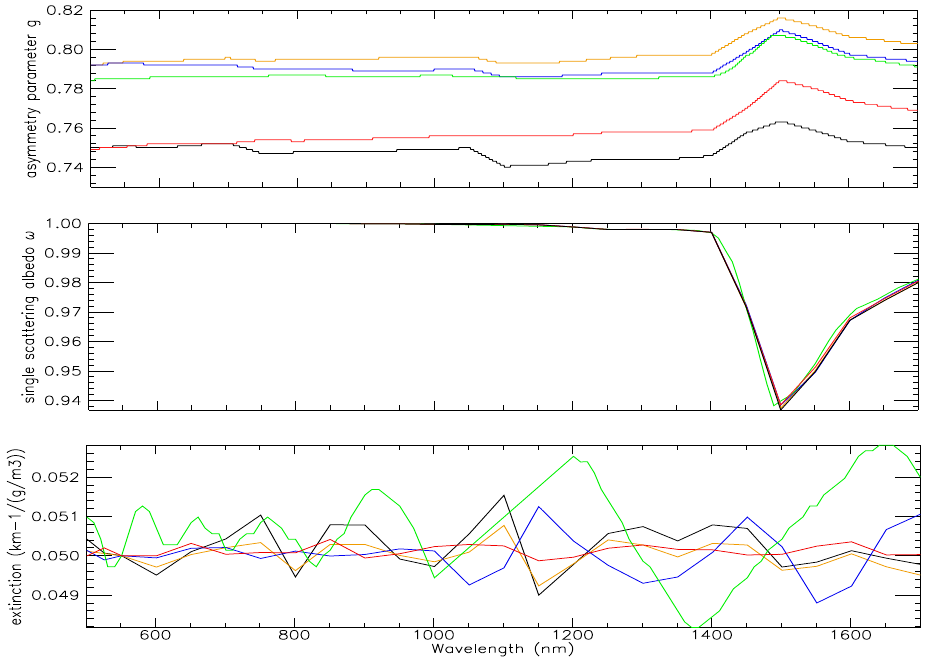
Fig. 7. Parametrized spectral optical properties for a mixture of ice crystals (green), droxtals (blue), aggregates (red), solid columns (black) and hollow columns (yellow).